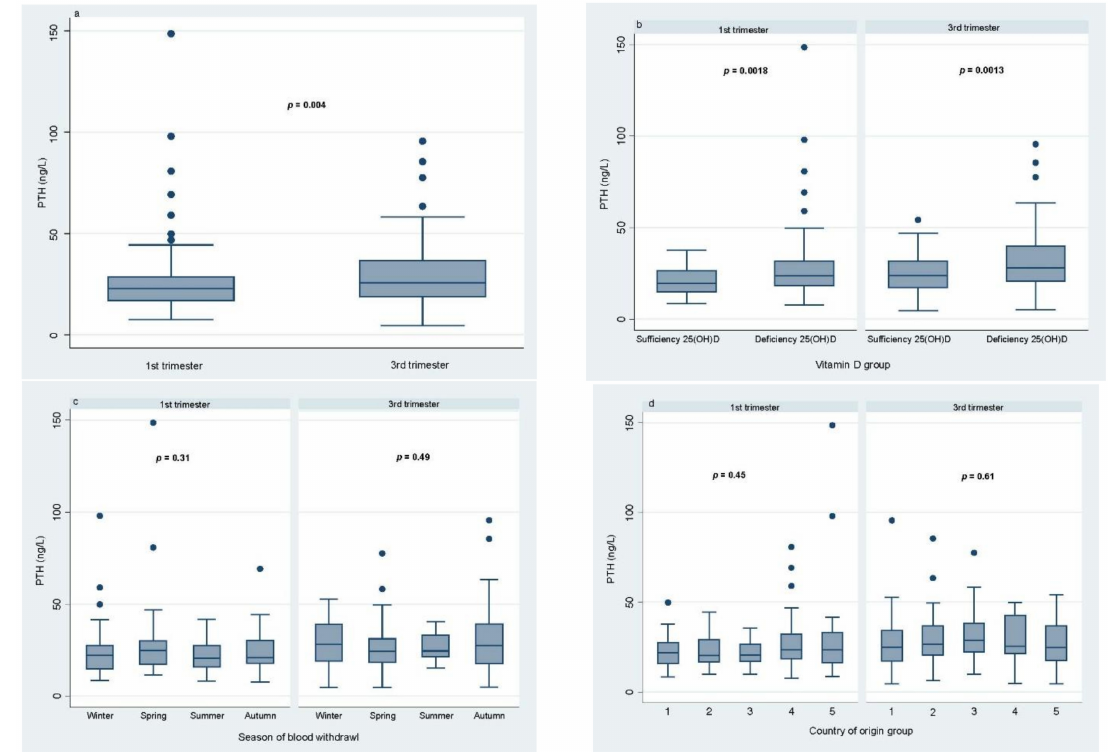
Figure 1. Serum PTH concentrations (ng/L) by ( a ) 1st and 3rd trimesters of pregnancy, ( b ) vitamin D group (sufficient = 25(OH)D ≥ 20 ng/mL (50 nmol/L) or deficient = 25(OH)D < 20 ng/mL), ( c ) season of blood withdrawal, and ( d ) country of origin. Boxplots represent the median, 1st, and 3rd quartiles of the complete cases; bars indicate minimum and maximum; dots indicate outliers.